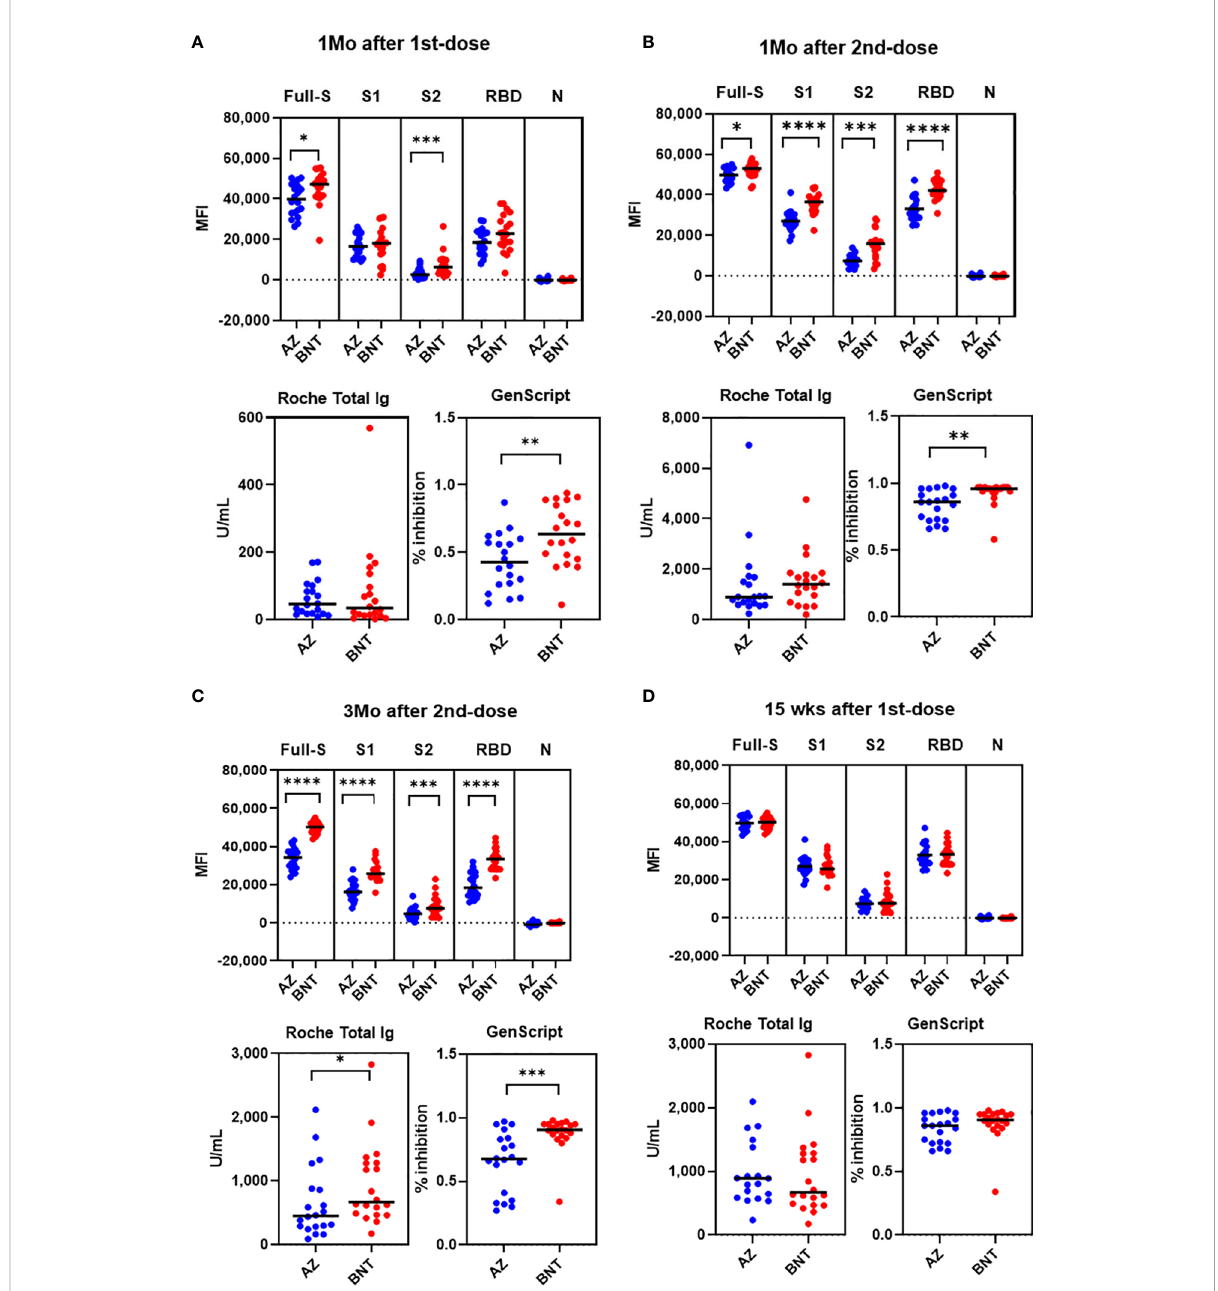
FIGURE 5 Comparison of SARS-CoV-2 antibody levels by Luminex bead assays, Roche and GenScript assays between AZ and BNT vaccination 1 month after 1st-dose (A) , 1 month after 2nd-dose (B) , 3 months after 2nd dose (C) and 15 weeks after 1st dose (D) . *P < 0.05, **P < 0.01, ***P < 0.001, ****P <